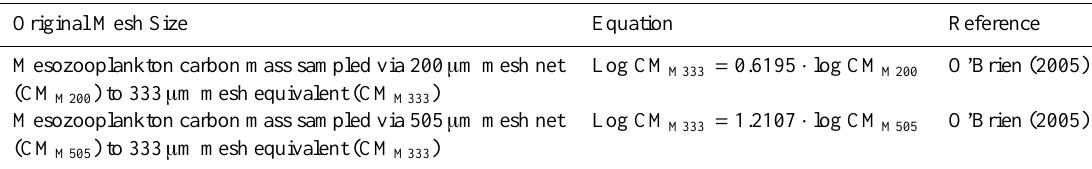
Figure 2. Biomass and biovolume sampling mesh distribution: (a) frequency distribution of mesh size ( µ m), (b) distribution of 333 µ m, (c) 200 µ m and (d) 505 µ m mesh catches. Table 3. Sampling mesh conversion